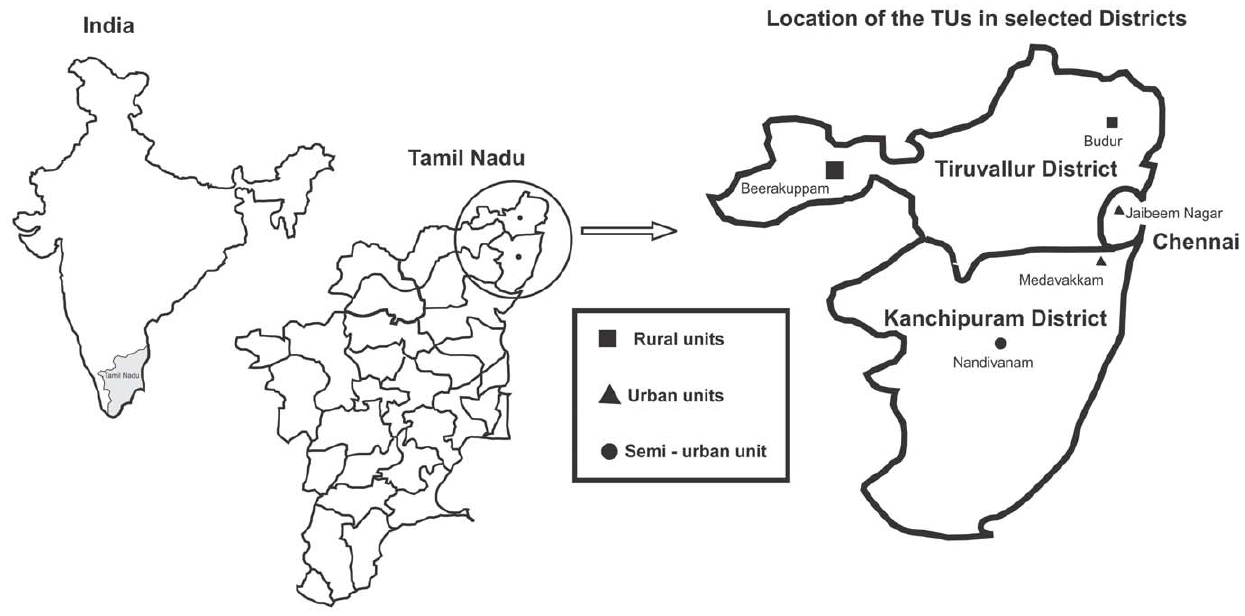
Figure 1. Location of selected Tuberculosis Units in three districts of Tamil Nadu, India.